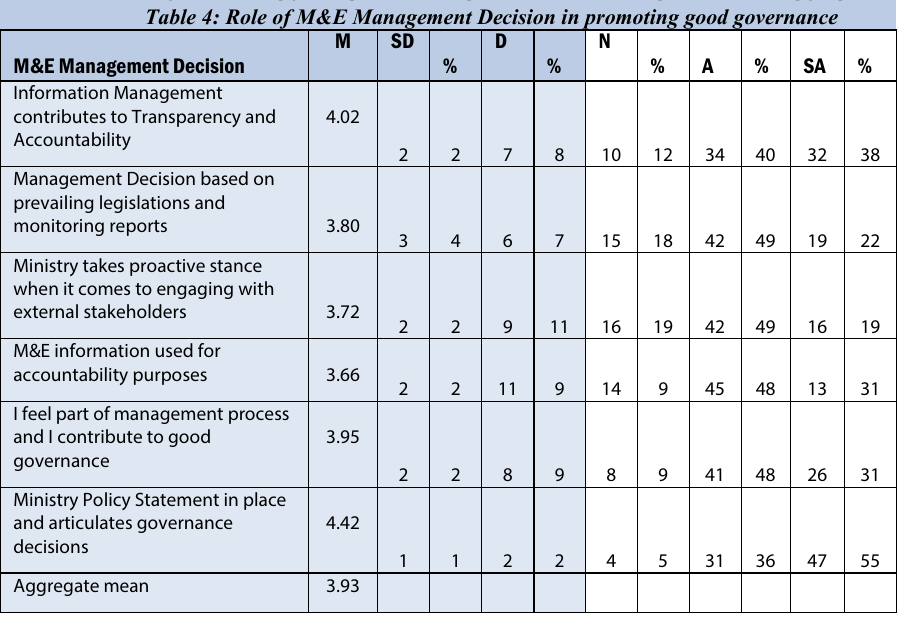
Table 4: Role of M&E Management Decision in promoting good